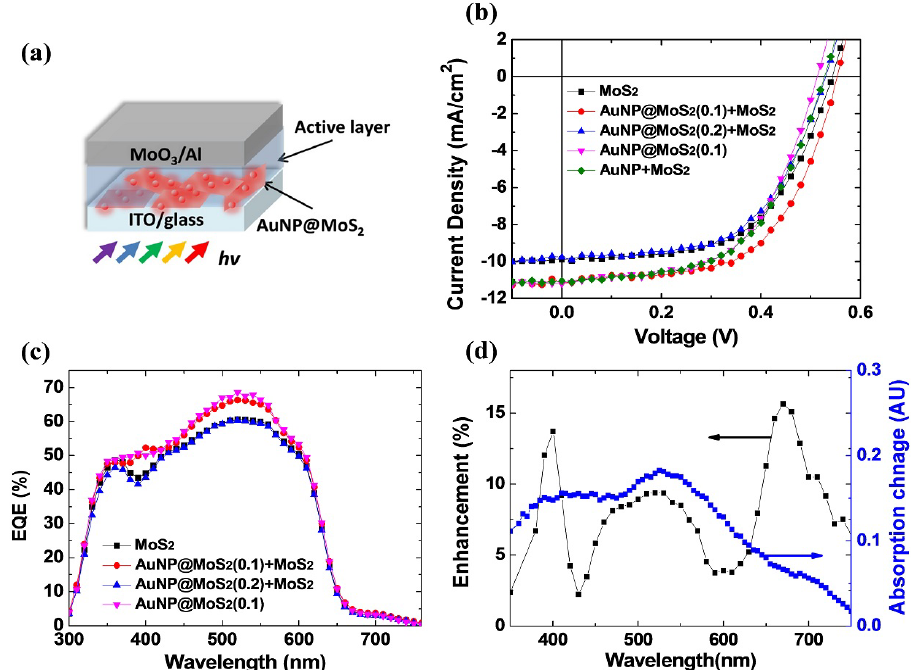
Figure 4. ( a ) The schematic representation of the device structure in this work; ( b ) J-V curves of the organic photovoltaic devices (OPVs) prepared with various MoS 2 nanocomposites; ( c ) Corresponding external quantum efficiency (EQE) curves of these devices; ( d ) The calculated EQE enhancement of the device prepared with the AuNP@MoS